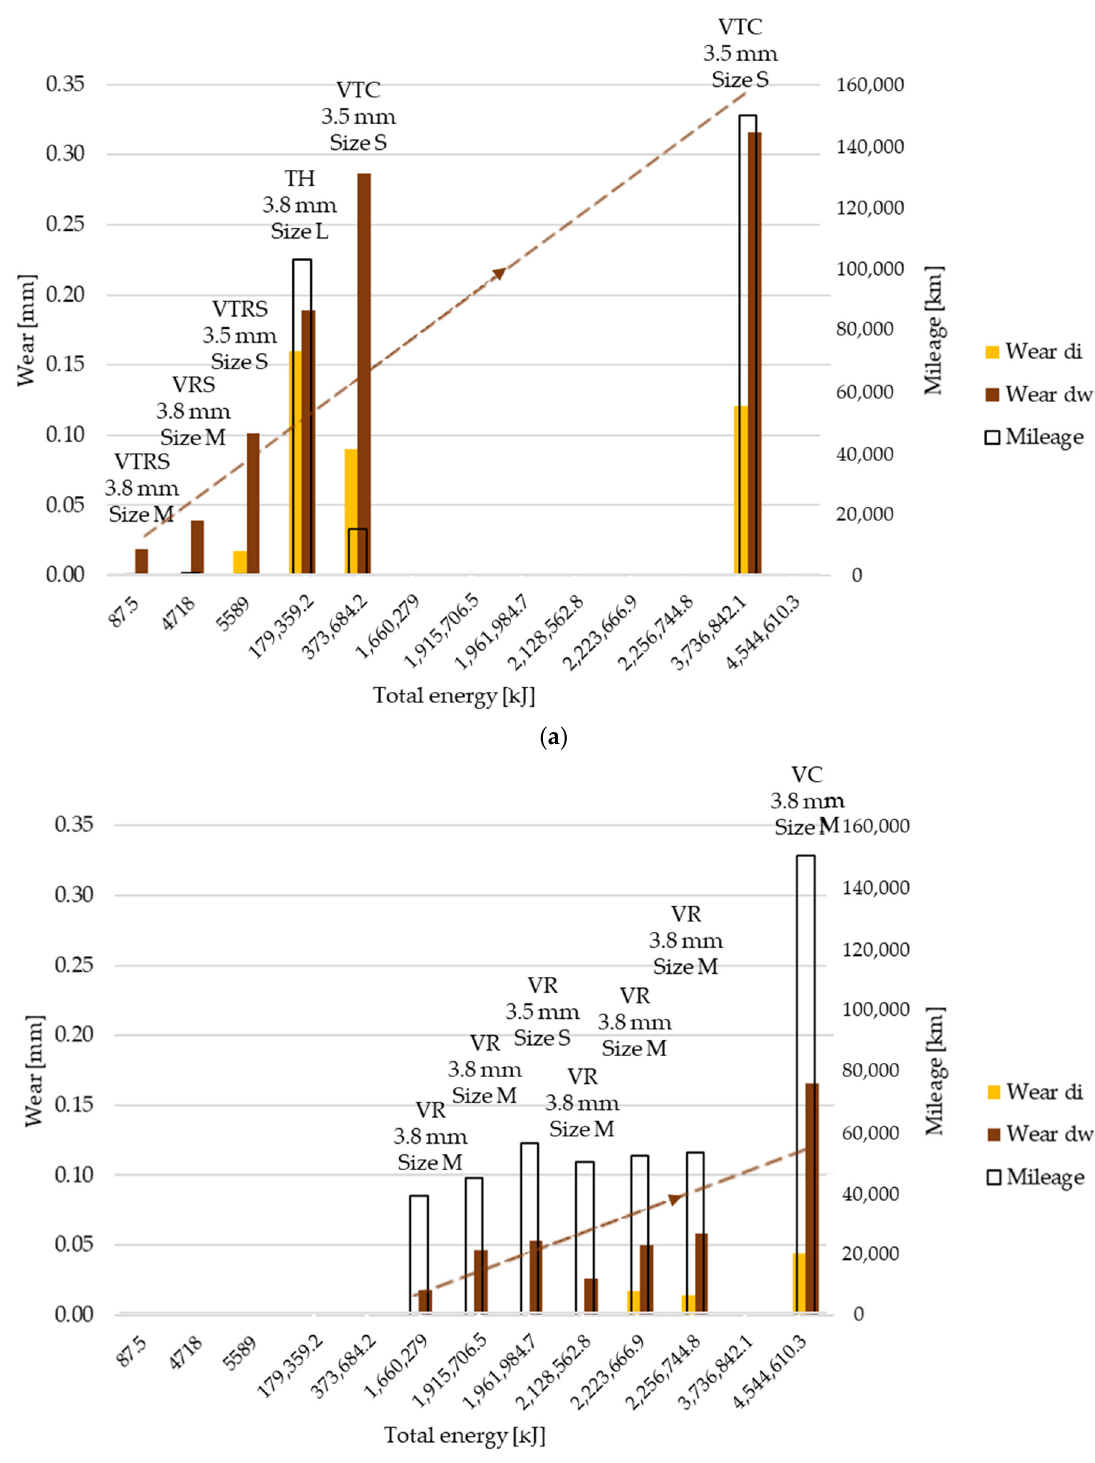
Figure 3. ( a ) Wear values on inner and working diameter with mileage along Joule-scale–trend 1: increasing, clutch killer load cases: VTRS, VRS, TH, VTC. ( b ) Wear values on inner and working diameter with mileage along Joule-scale–trend 2: increasing, moderate load cases: VR, VC (high mileage).